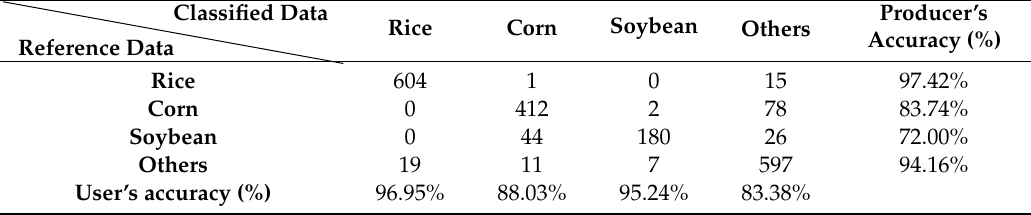
Table 5. Confusion matrix of crop layer with feature sorting but without optimization.